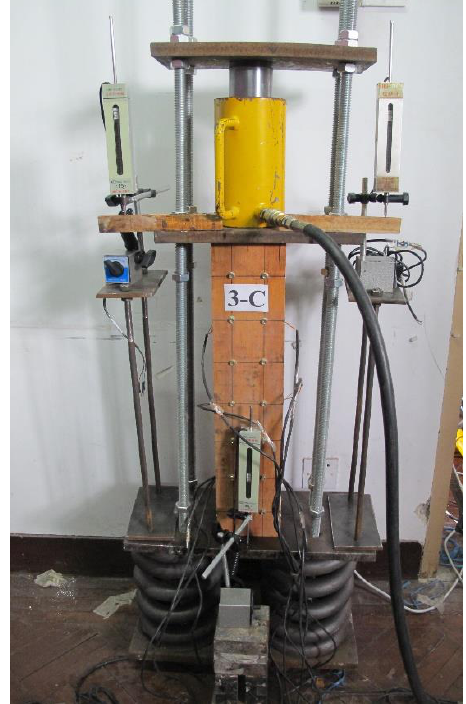
Figure 3. Device for long-term loading.